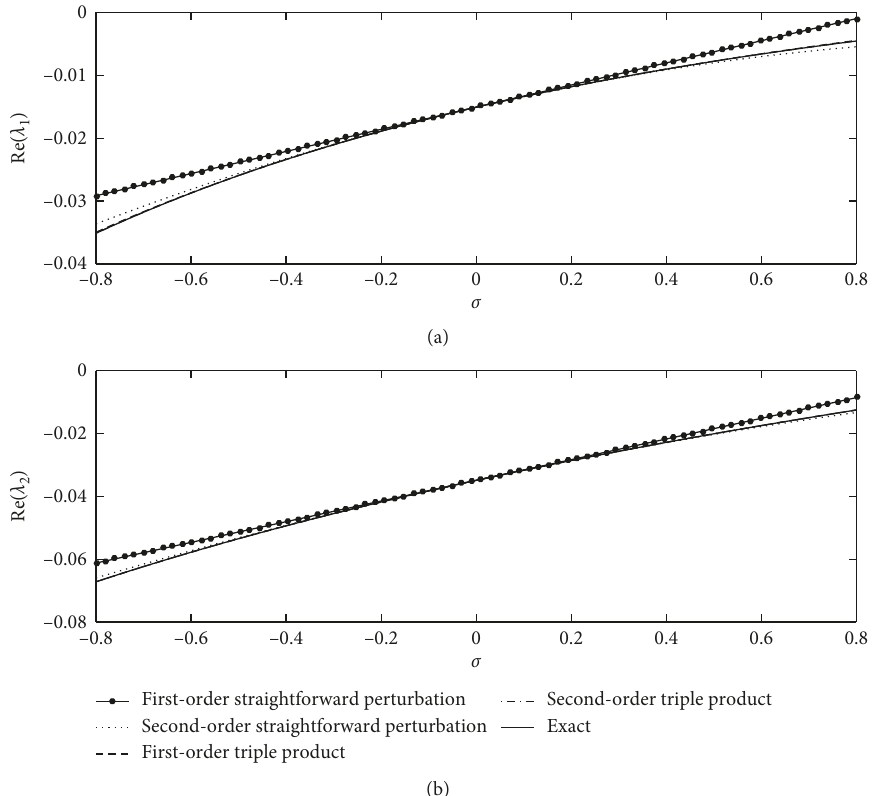
Figure 6: The real parts of the exact and approximate eigenvalues of the two-degree-of-freedom gyroscopic system as a function of σ